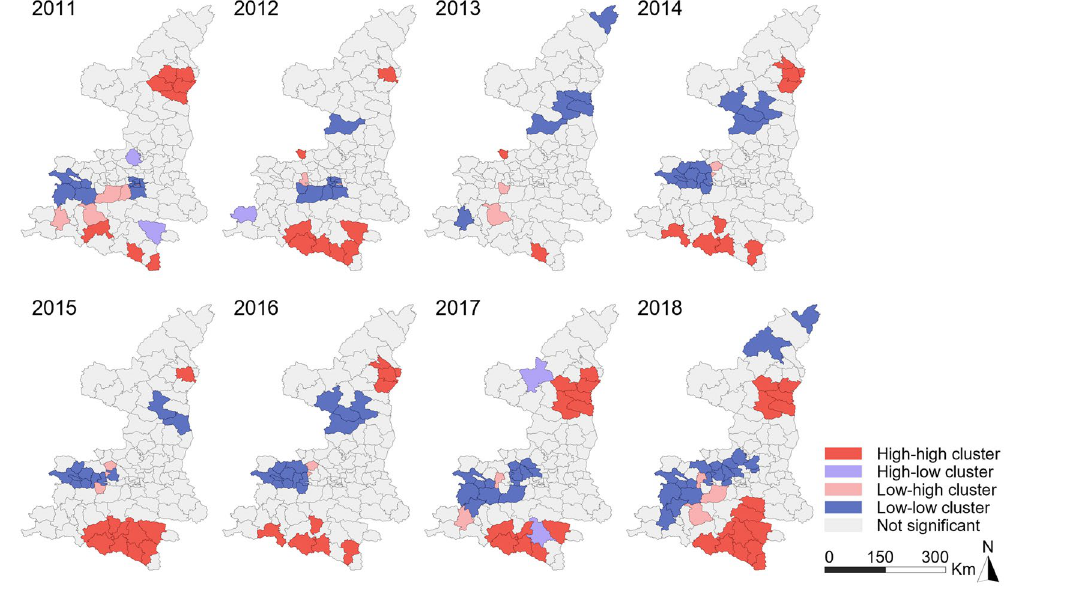
Figure 5. LISA cluster map for